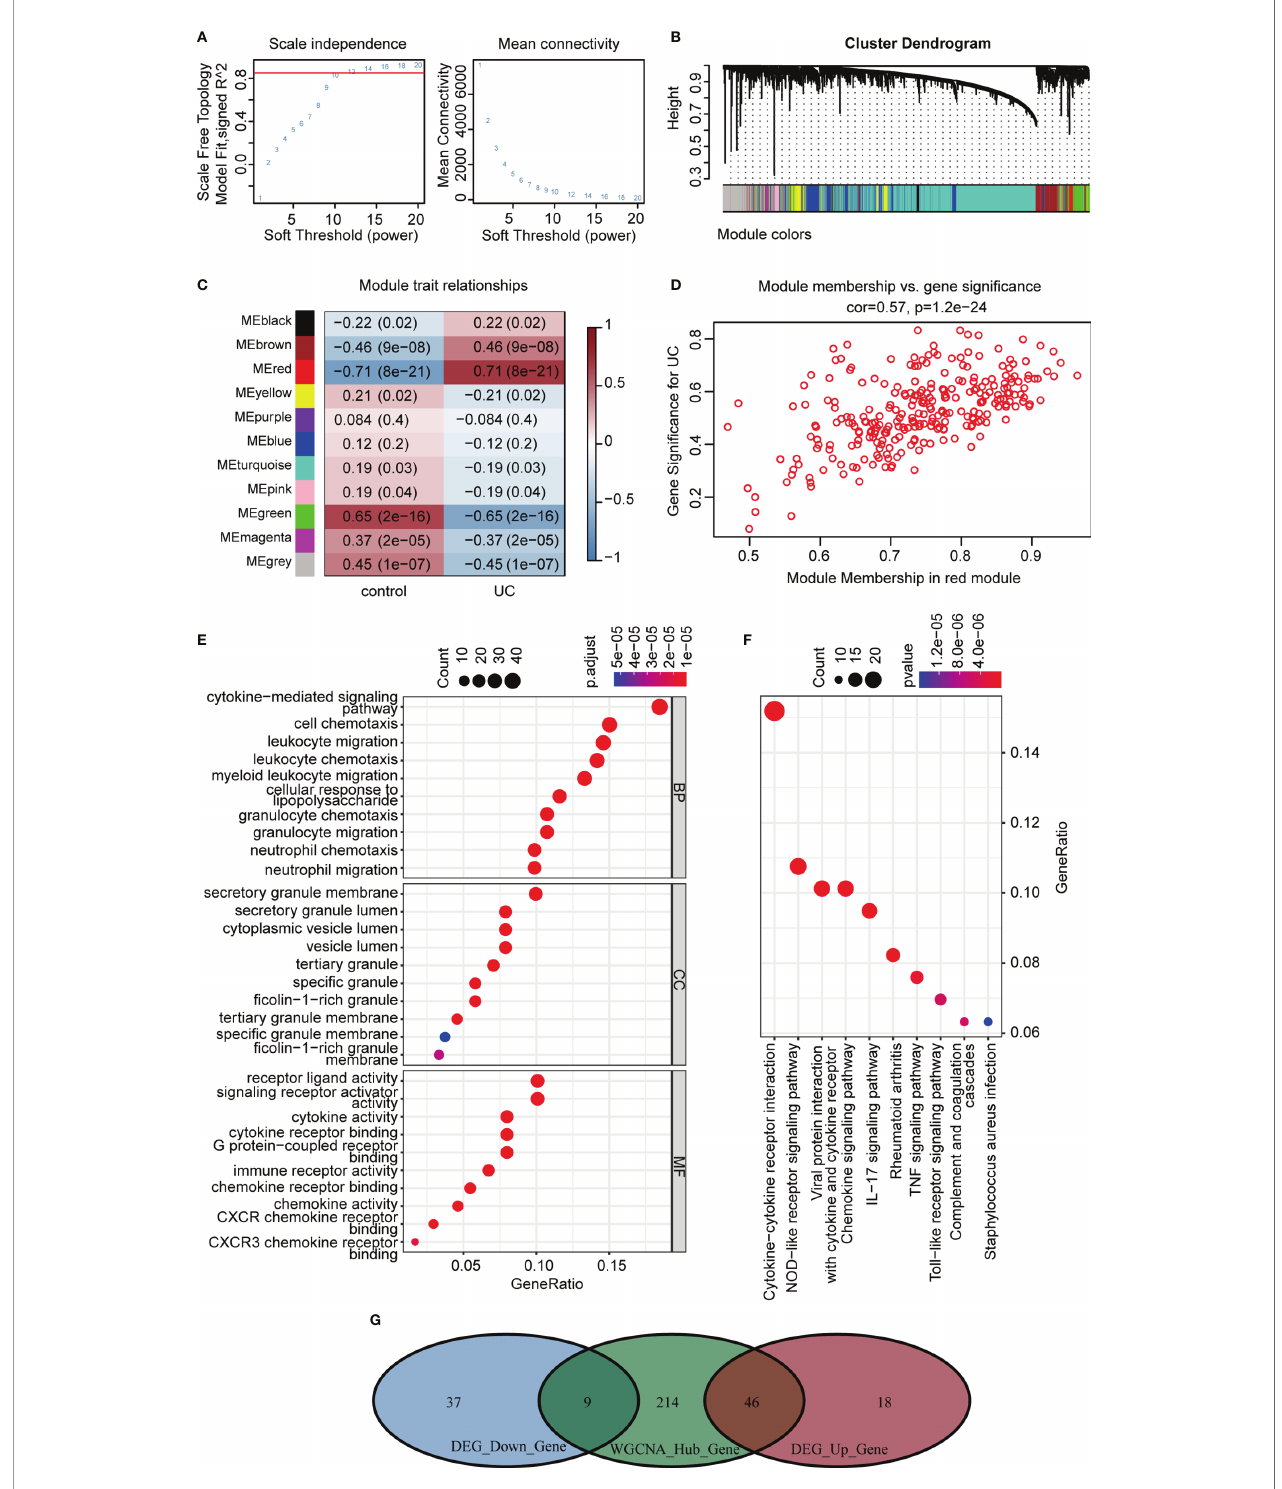
FIGURE 5 | WGCNA analysis of GSE87473. (A) Soft threshold power screening and scale-free network construction. (B) The hierarchical clustering tree shows the network and the 11 identi fi ed modules. (C) Heatmap plot shows the adjacencies in the eigengene network. Correlation of each module with active UC. (D) A scatterplot of gene signi fi cance (GS) versus module membership (MM) in the red module. (E, F) GO and KEGG enrichment analysis of the red module. (G) Venn diagram of the overlapping